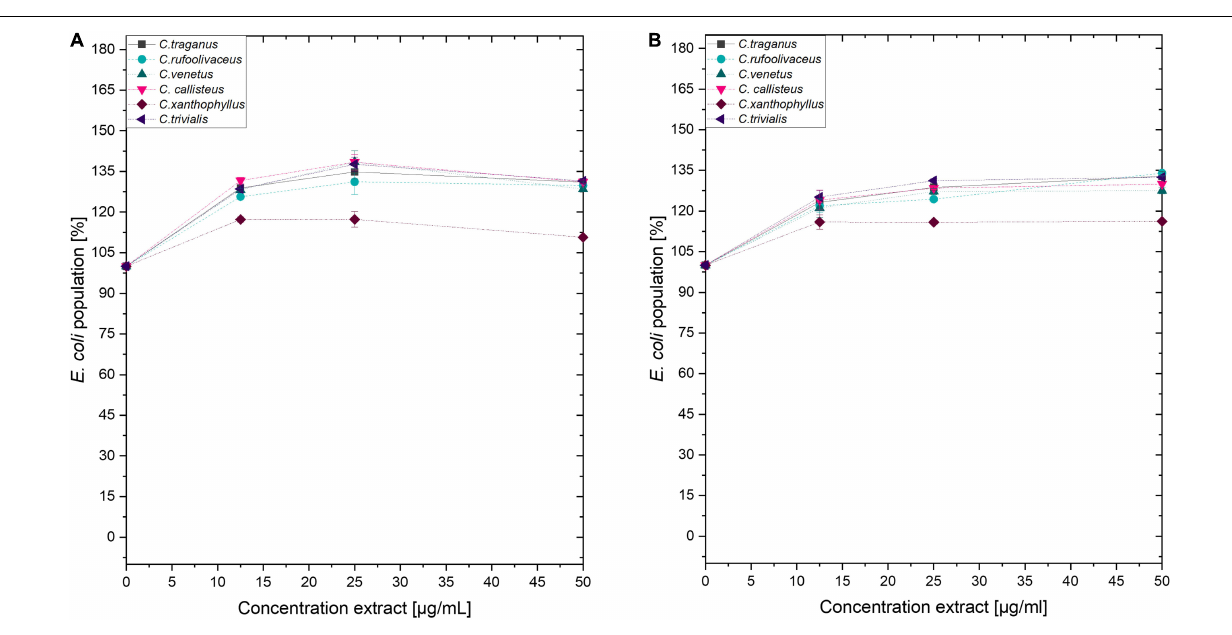
FIGURE 7 | Dose–response curves of E. coli treated with Cortinarius extracts. On the left side, (A) dark controls are shown. The right graph (B) represents the irradiated experiments ( λ = 478 nm, 30 J/cm 2 , PI = 60